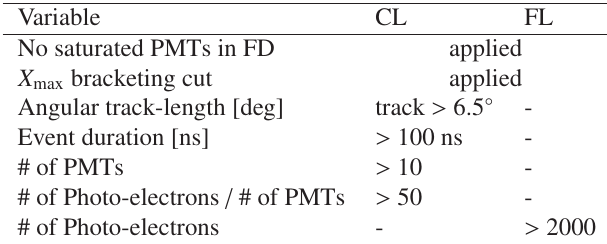
Table 1: Quality cuts applied in this work. Here we define fluorescence events as fractional contribution to the total signal of Fluorescence Light (FL) > 0.75, and Cherenkov Light (CL) events as fractional contribution to the total signal of FL ≤ 0.75.